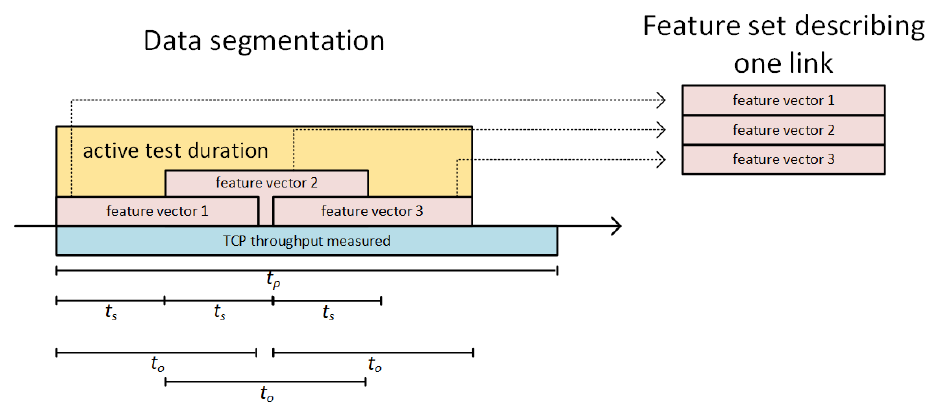
Figure 8. A segmentation procedure with illustration of its parameters ( t o , t s ) resulting in obtaining of 3 segments ( M = 3).